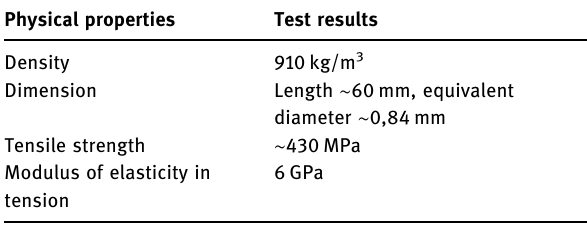
Table 6: Technical data of SikaFiber ® Force -